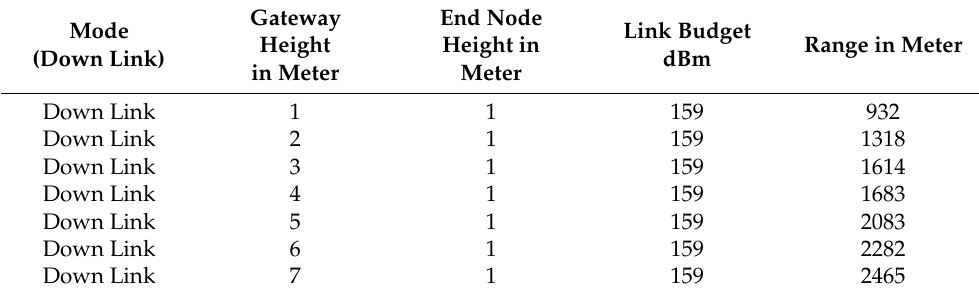
Table 4. Range and link budget at node sensitivity—124 dBm.